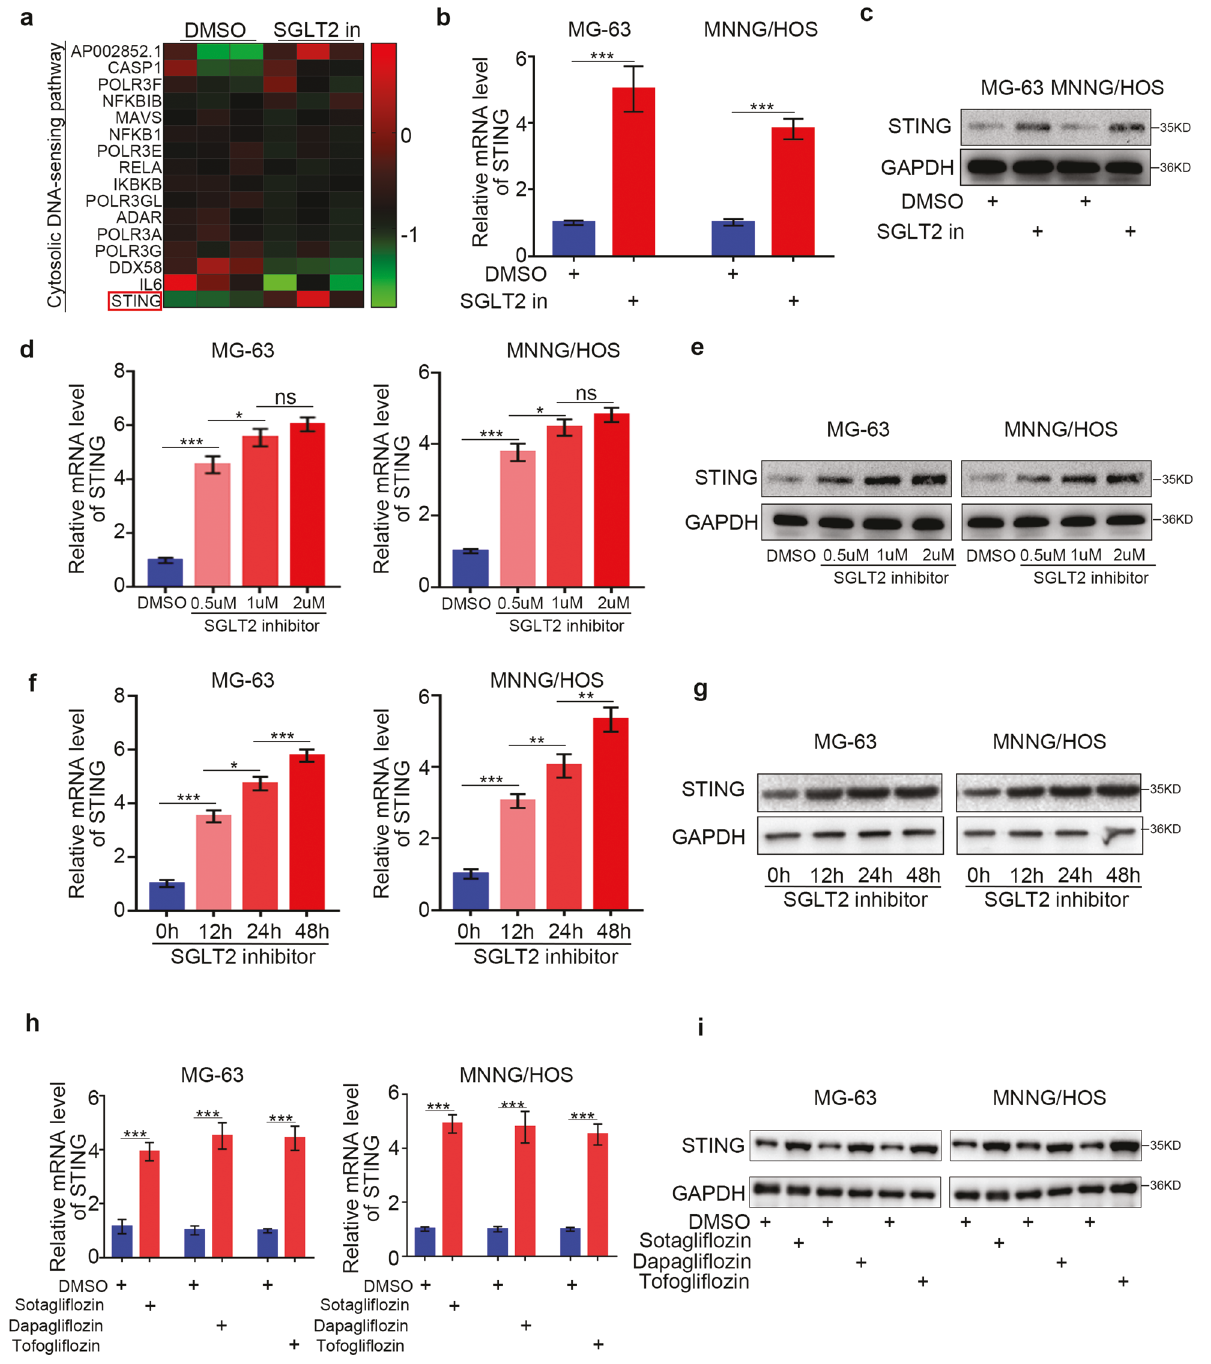
Fig. 4 SGLT2 inhibitor-induced STING expression in osteosarcoma cells. a Heatmap of the SGLT2 inhibitor treatment-related genes that participated in the cytosolic DNA-sensing pathway in MNNG/HOS cells. RT-PCR ( b ) and Western blot ( c ) analyses of the mRNA and protein expression levels of STING in MG-63 and MNNG/HOS cell lines treated with DMSO or SGLT2 inhibitor (canagli fl ozin, 1 uM) for 24 h. GAPDH served as an internal reference. RT-PCR ( d ) and Western blot ( e ) analyses of the mRNA and protein expression levels of STING in MG-63 and MNNG/HOS cell lines treated with DMSO or SGLT2 inhibitor (canagli fl ozin; 0.5, 1, or 2 uM) for 24 h. Data are presented as the mean ± SD of three independent experiments (ns not signi fi cant; * p < 0.05; *** p < 0.001). RT-PCR ( f ) and Western blot ( g ) analyses of the mRNA and protein expression levels of STING in MG-63 and MNNG/HOS cell lines treated with SGLT2 inhibitor (canagli fl ozin, 1 uM) for 0, 12, 24 or 48 h. Data are presented as the mean ± SD of three independent experiments (* p < 0.05; ** p < 0.01; *** p < 0.001). RT-PCR ( h ) and Western blot ( i ) analyses of the mRNA and protein expression levels of STING in MG-63 and MNNG/HOS cell lines treated with Sotagli fl ozin (200 nM), Dapagli fl ozin (100 nM), and Tofogli fl ozin (100 nM) for 24 h, respectively. Data are presented as the mean ± SD of three independent experiments (* p < 0.05; ** p < 0.01; *** p <